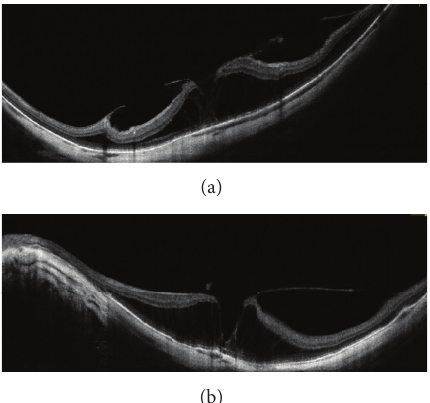
Figure 2: OCT images of myopic eye. Myopic foveoschisis associ- ated with tangential traction due to ERM and